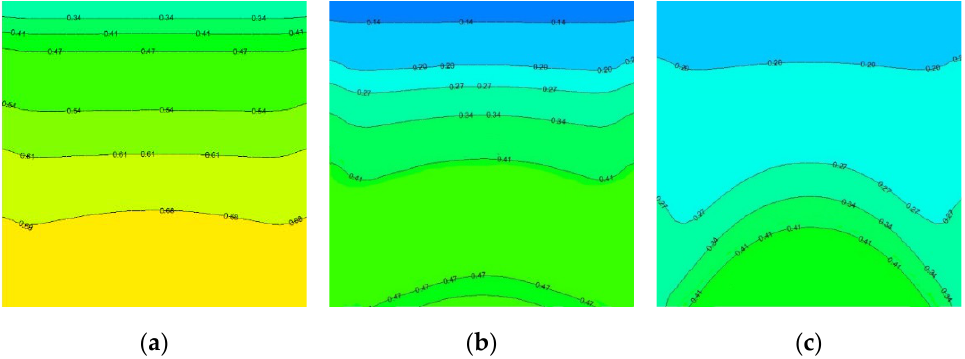
Figure 10. Remaining oil distribution of each layer after subsequent water flooding stage of Figure 1: ( a ) low-permeability layer, ( b ) medium-permeability layer, ( c ) high-permeability layer . Table 6. The remaining oil saturation (%) results of Figure 1 .